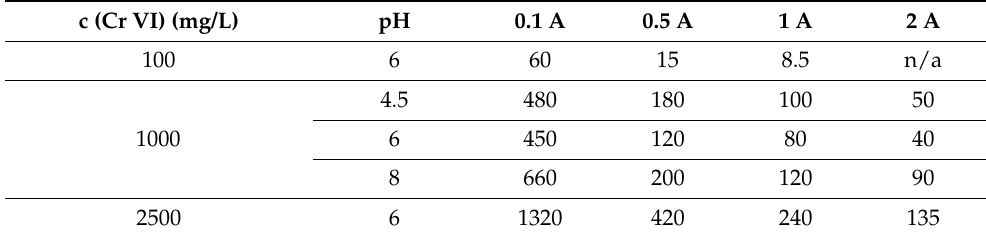
Table 2. Minutes until the chromium concentration was zero in the solution. c (Cr VI)